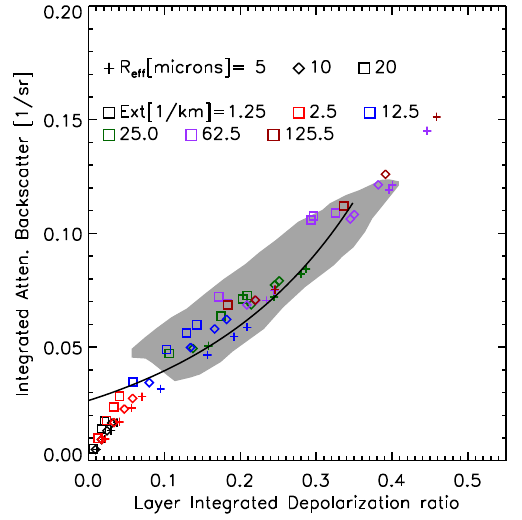
Figure A3. Layer integrated integrated backscatter vs. layer inte- grated depolarisation ratio. The symbols show the results of 532nm CALIPSO ECSIM simulations for different layer effective radii and extinction coefficients as indicted in the figure legend. The grey-shaded area represents the area within the “frequency-of- occurrence = 20” level shown in Fig. 3 of Hu et al. (2007) for actual CALIPSO observations. The line denotes γ = 1 sr) following and using the notation of Hu et al.